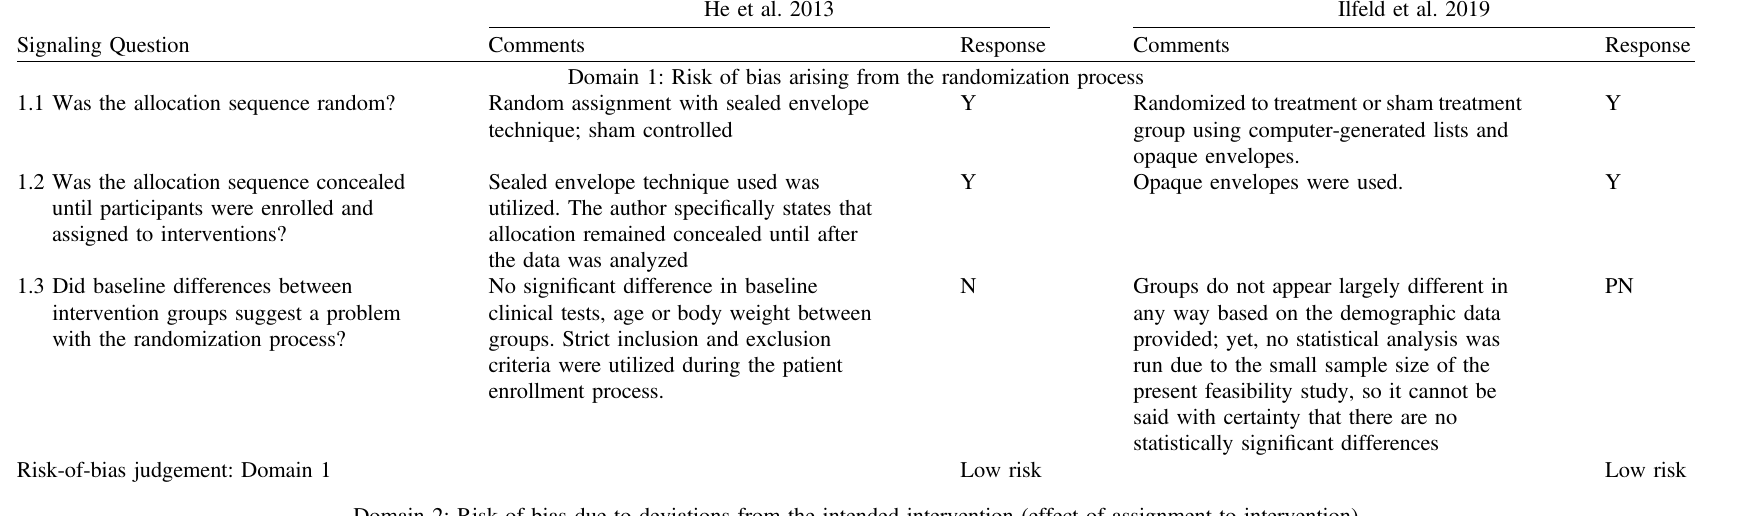
Table 2. ROB assessment for randomized controlled trials: Revised Cochrane ROB tool for Randomized